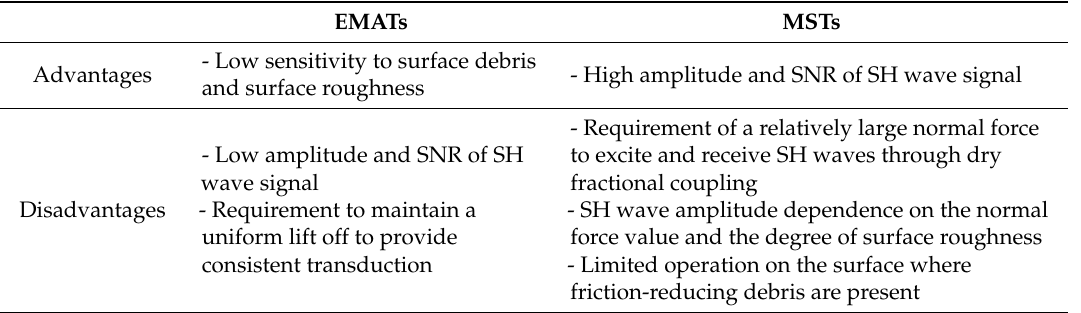
Table 5. Summary of the experimental